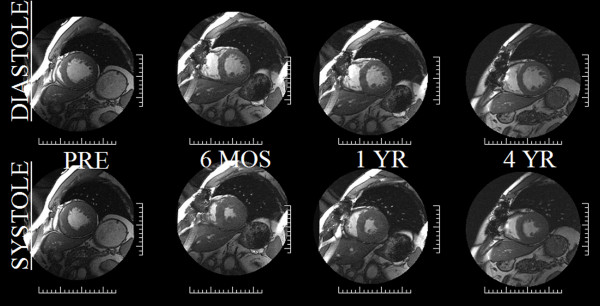
Serial cardiovascular MRI mid short-axis images in diastole (top row) and systole (bottom row) in a 76 WM taken the day prior to AVR, 6 months, one year and 4 years following AVR. The LV mass decreased from 186 to 154 g over the first 6 months to only regress to 132 g over the next 3 1/2 years demonstrating the early-rapid and late-slow pattern of LVH regression. Similarly, LVEF markedly improved after afterload relief from 54% to 60% in the first 6 months with no further improvements over the ensuing 3 1/2 years (62%).